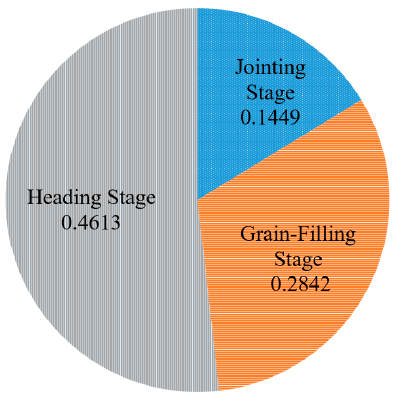
Figure 8. Contribution ratios of the three phenological phases.